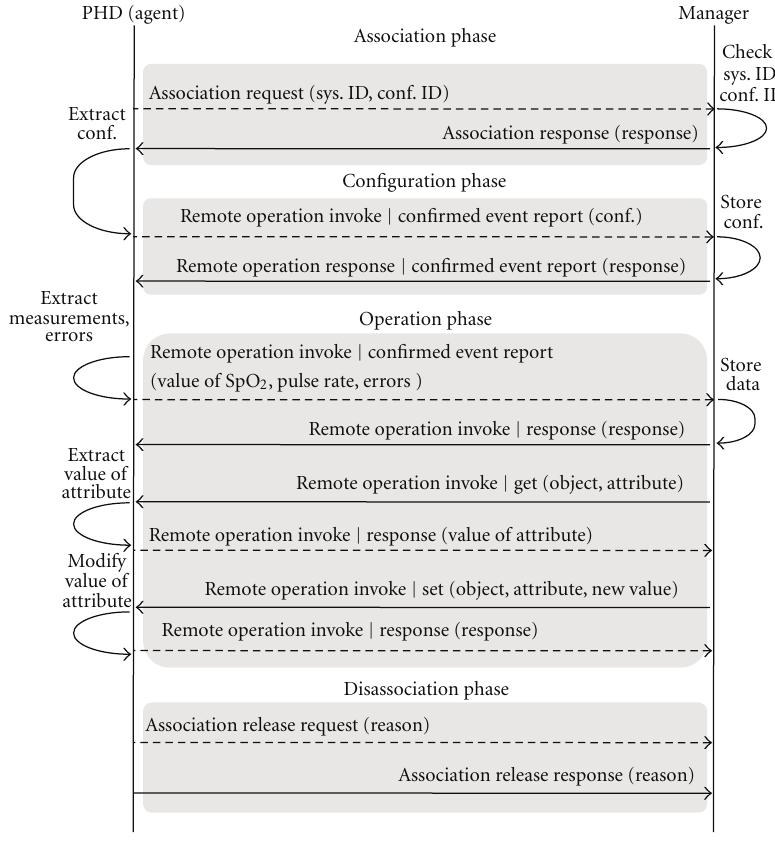
Figure 1: Communication